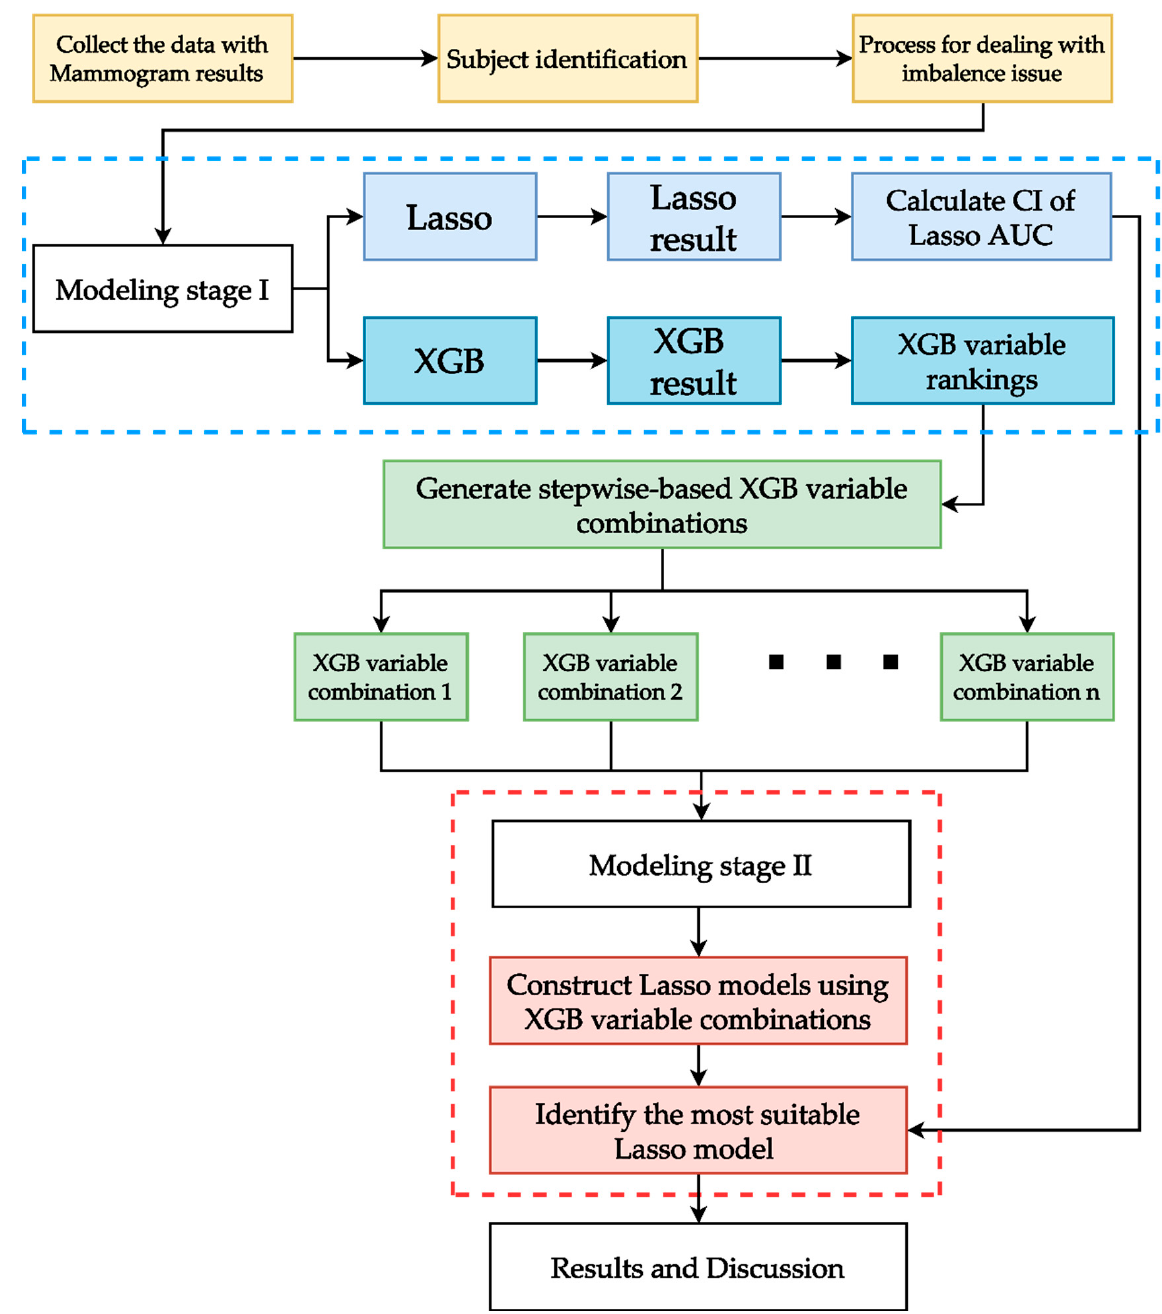
Figure 3. Proposed integrated ML scheme.